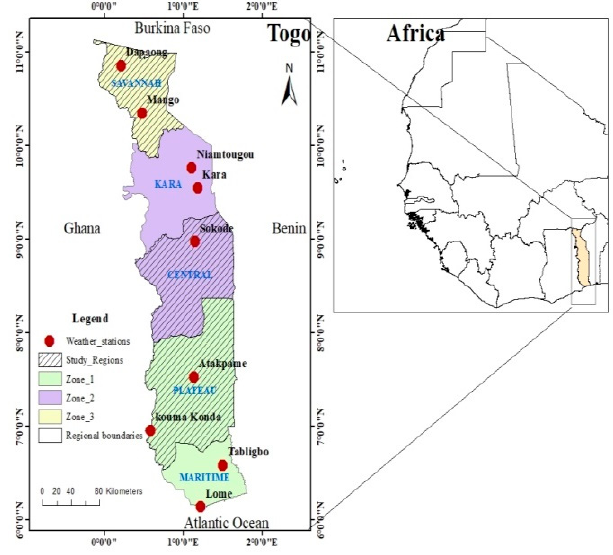
Figure 1. Study area, national weather stations, and climate change vulnerability zones in Togo.